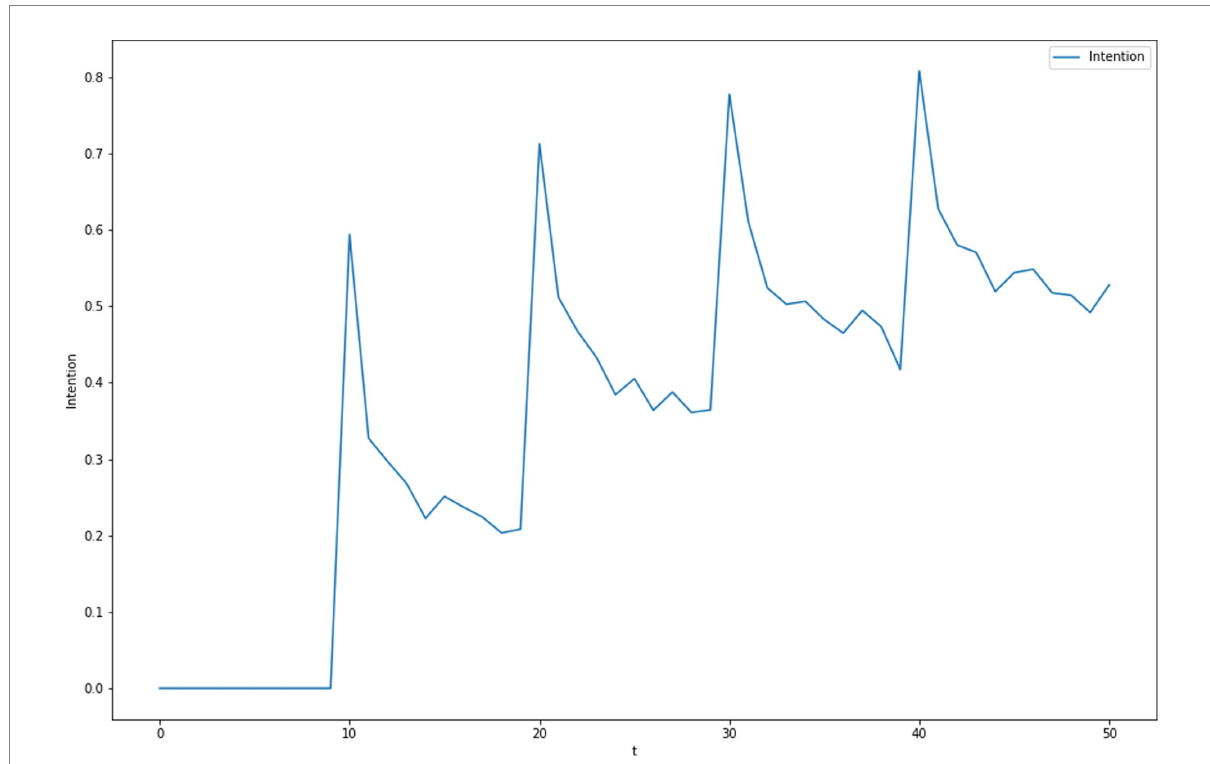
FIGURE 2 Dynamics of subjective intentions that start a level of zero but messaging at t = 10, 20, 30, 40 promotes a higher level of